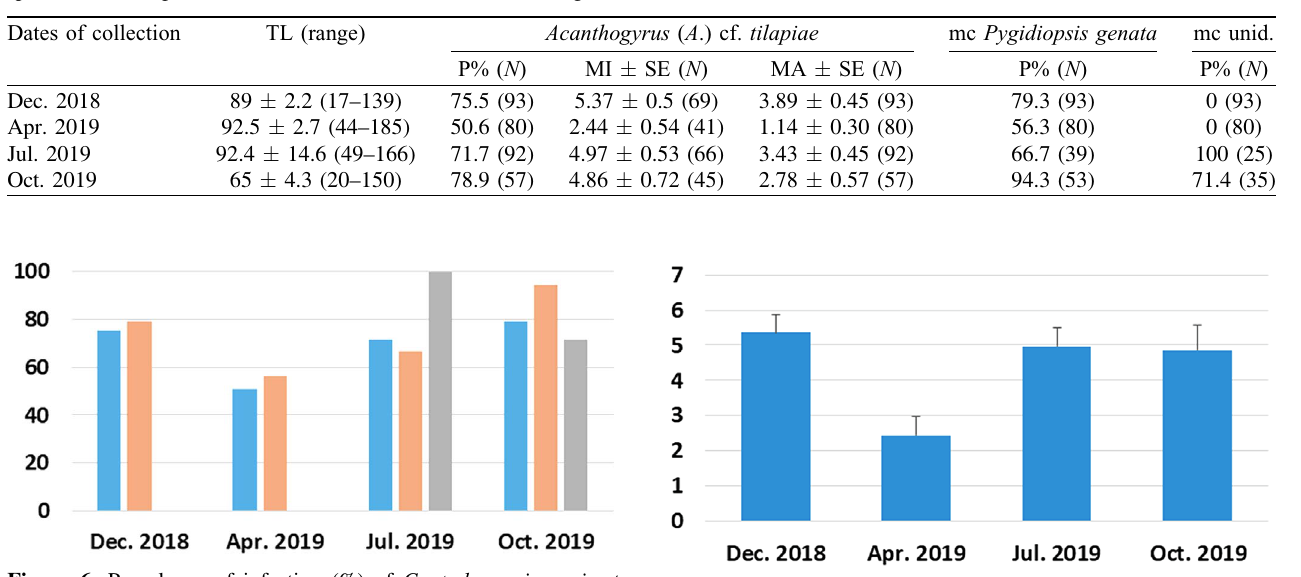
Table 5. Prevalence (P), mean intensities (MI), and mean abundance (MA) of infection of Coptodon guineensis at Sebkha Imlili by acanthocephalan Acanthogyrus ( Acanthosentis ) cf. tilapiae and metacercariae (mc) of Pygidiopsis genata and of an unidenti fi ed (unid.) species. N = sample size; SE = standard error; TL = Total length of fi sh in mm.